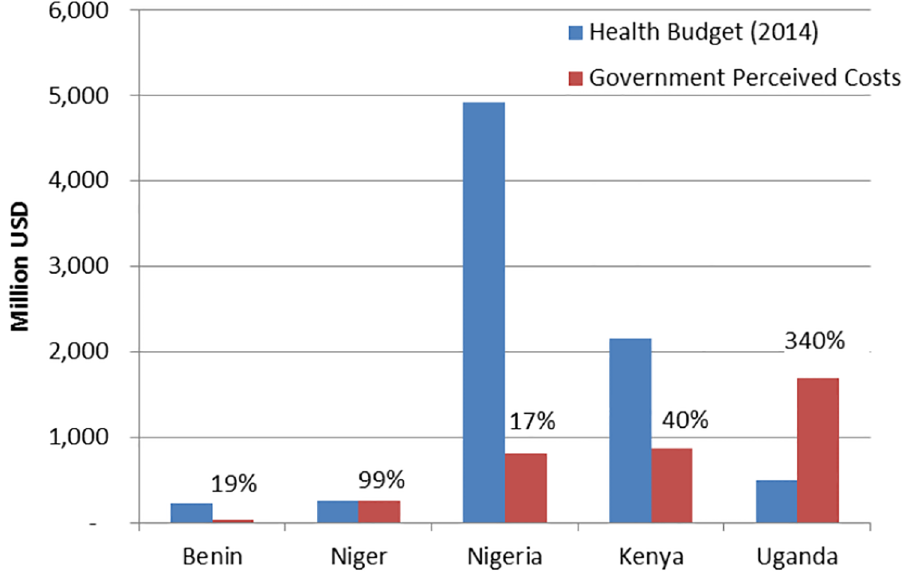
Fig 2. Comparing government perceived costs with health budget of 2014 [37]. Note. Parameter values: adoption ceilingof 40% after 20 years; discountrate r = 0.04; d = 0.5; elasticity of supply ε = 0 . 6 , elasticity of demand η = -0 . 3